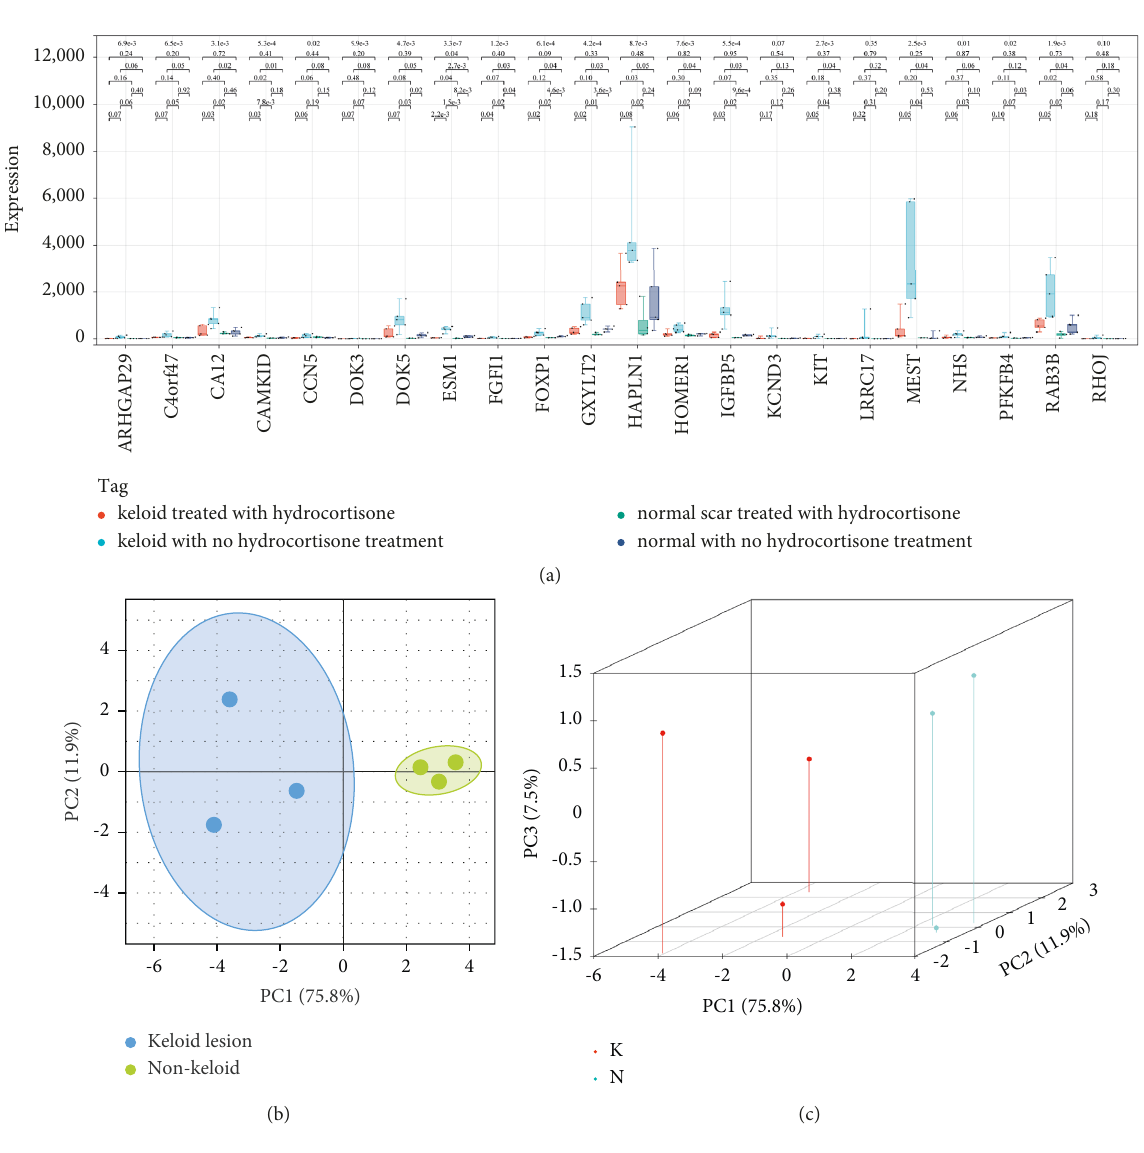
Figure 2: Expression levels of 22 DEGs in GSE7890 (a) and distinct separation using the expression feature of these 22 DEGs of keloid and nonkeloid lesions in GSE92566: (b) two-dimensional principal component analysis and (c) three-dimensional principal component